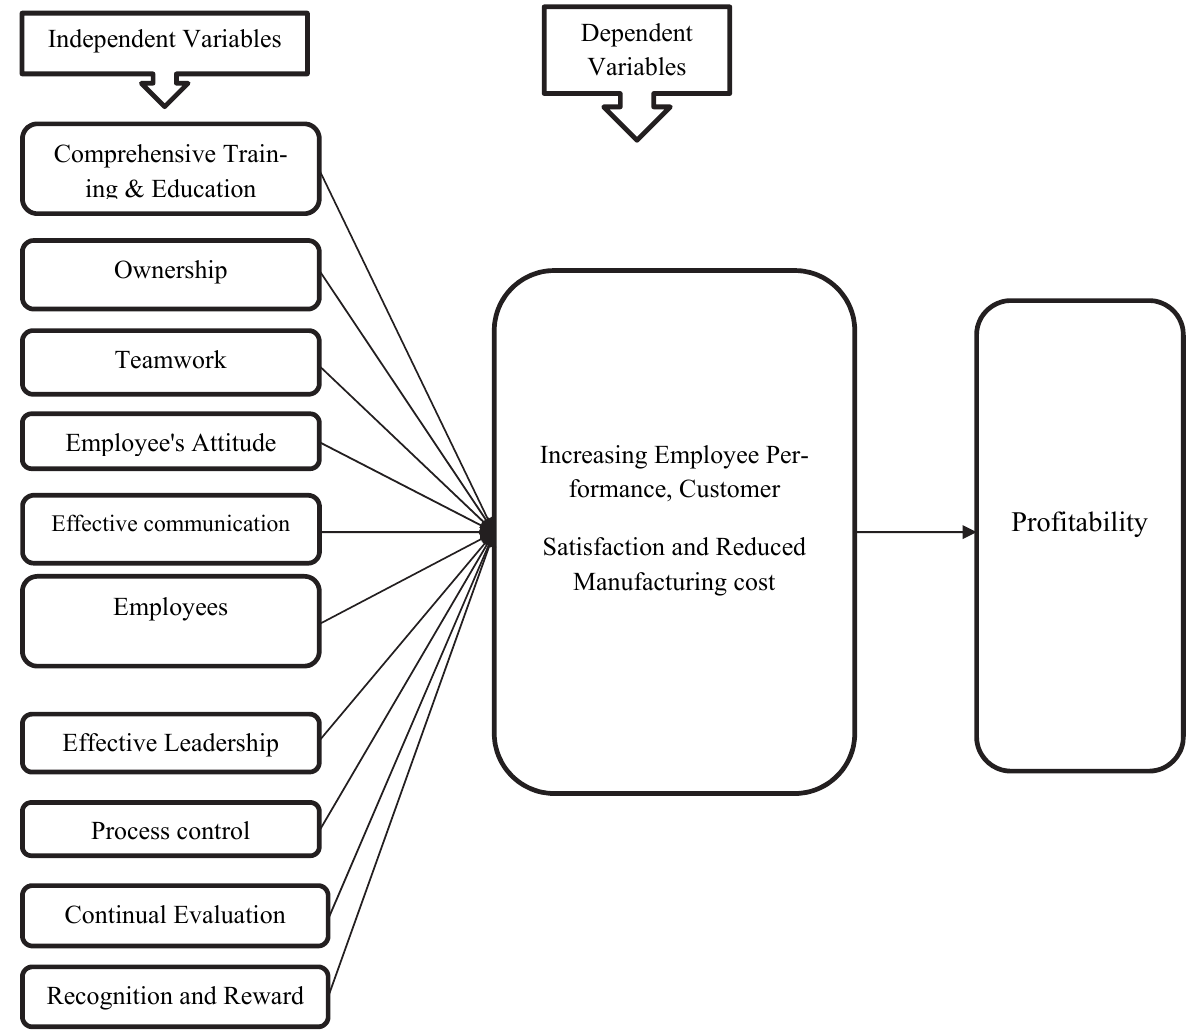
Fig. 2. Conceptual model before emperically